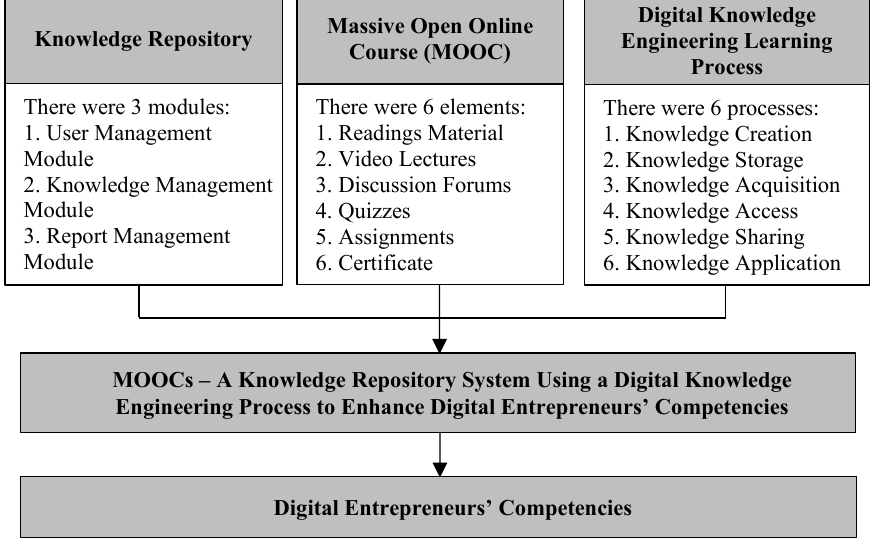
Fig. 3. Conceptual Framework for the Development of